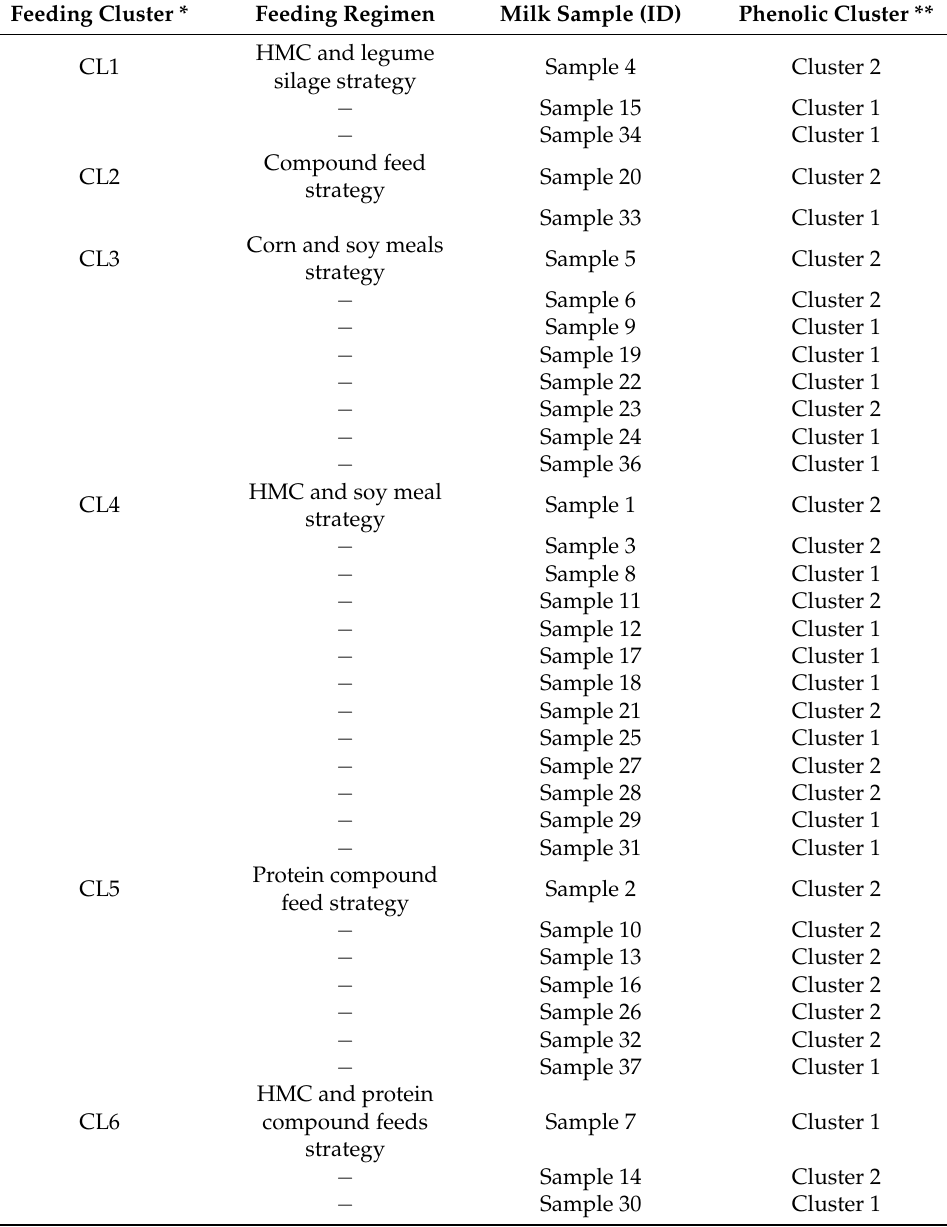
Table 1. Bulk milk samples under investigation, classified according to both the feeding regimen and the phenolic